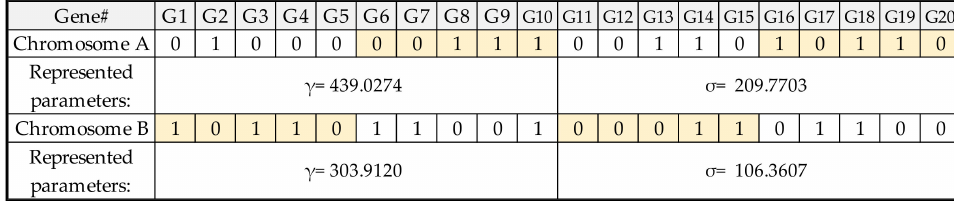
Figure 6. The binary encoding for parameters of LSSVR at the stage of initial